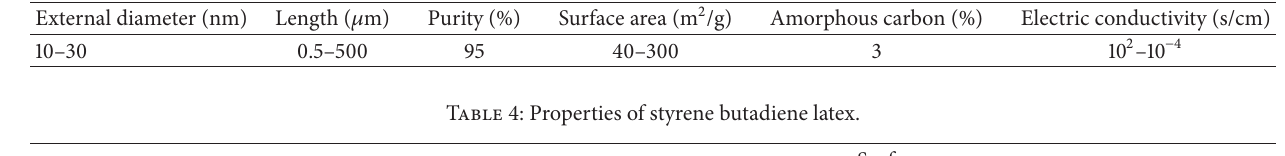
Table 3: Properties of carbon nanotube.